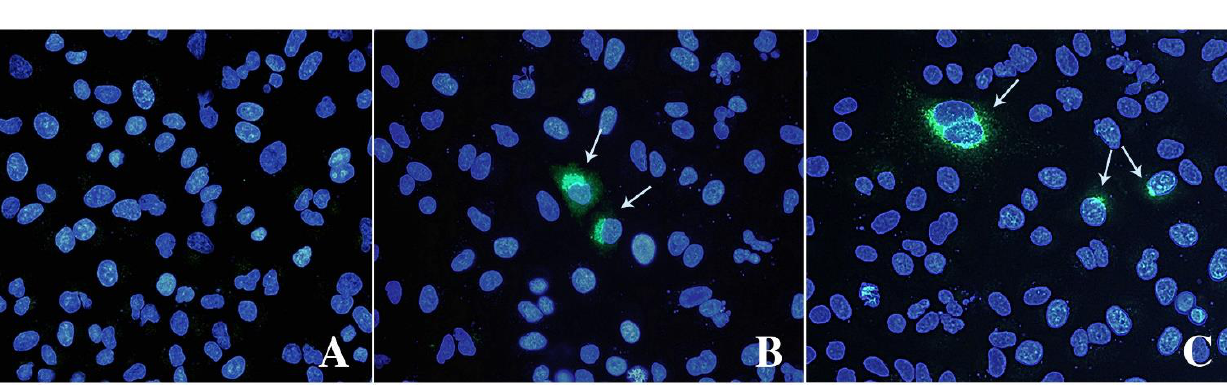
Figure 2. Transmission electron micrographs of infected cell supernatants, positive for HEV-RNA. Representative images of assembled virions ( A , B ) and protein aggregates ( C , D ). IPA and IFA indicated that virions observed with TEM can replicate and form replicative foci (Figure 3). Both assays revealed a limited number of stained cells, 3 – 4% of HEV positive cells counted by IPA, with cytoplasmic and perinuclear viral replication and assembly.